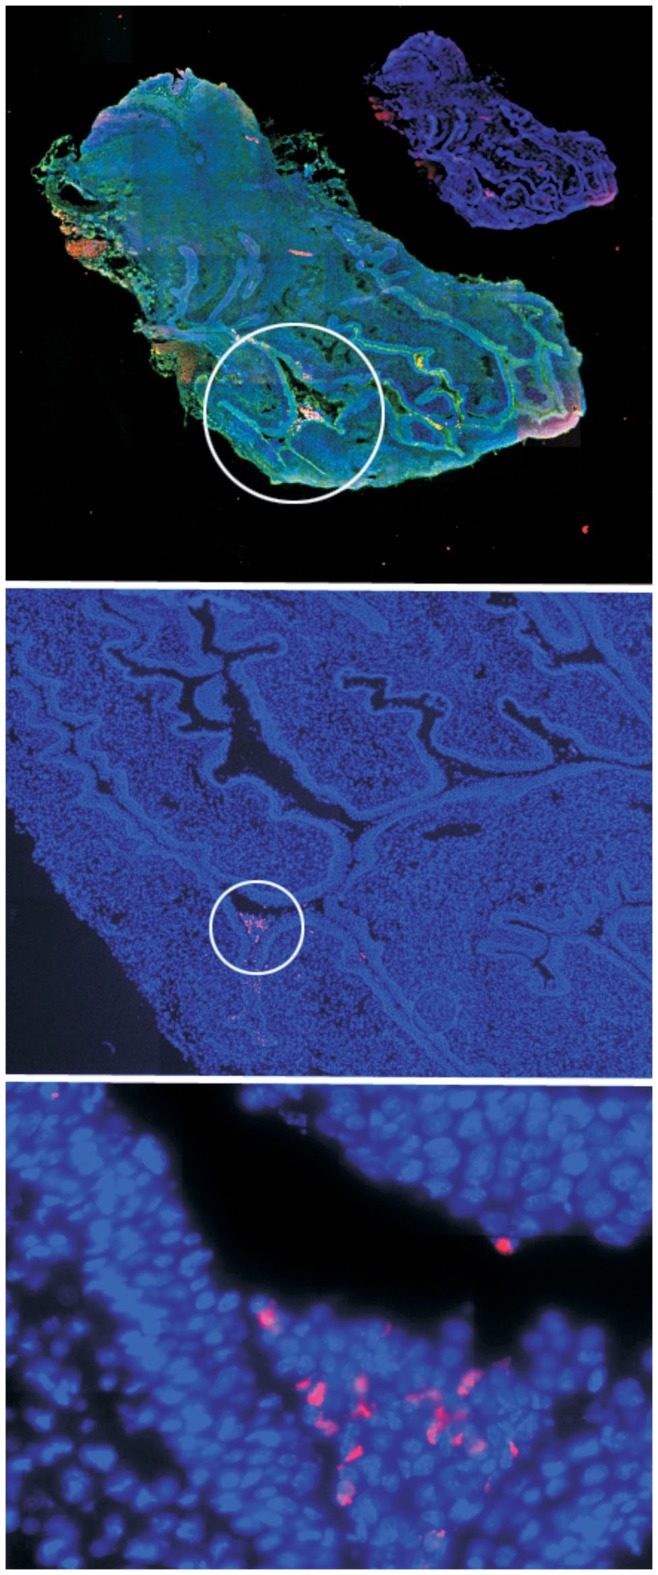
Qdots in vaginal wall close to cervix.Top to bottom, increasing magnification of circled areas. Red, Qdots; green, WGA (cell surfaces); blue, nuclei (DAPI). Note penetration of tissue in bottom figure. N-9 pretreatment and instillation were as described in Figure 1. Organs were harvested and flash-frozen without fixation 24 hr after Qdot instillation. Sectioning, staining and microscopy were as described in Materials and Methods.